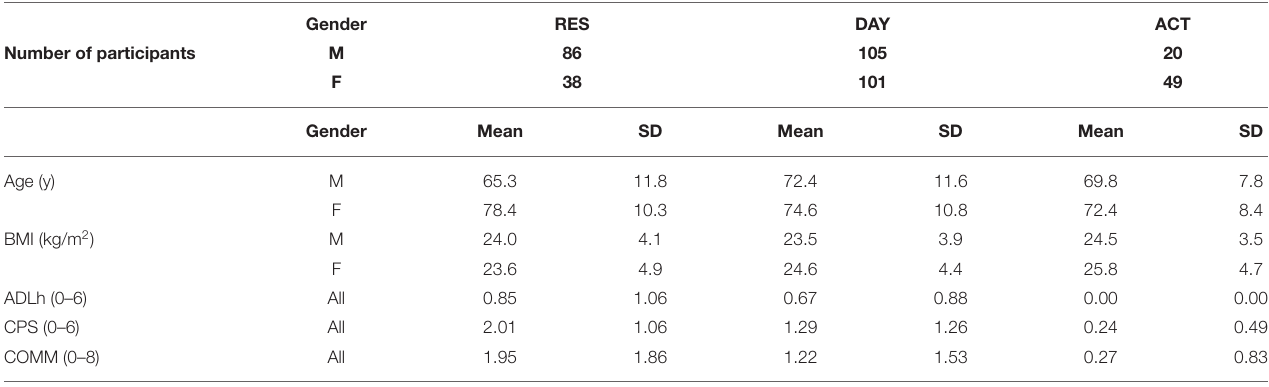
TABLE 1 | Participant characteristics ( N = 399) for the three types of organizations. Gender RES DAY Number of